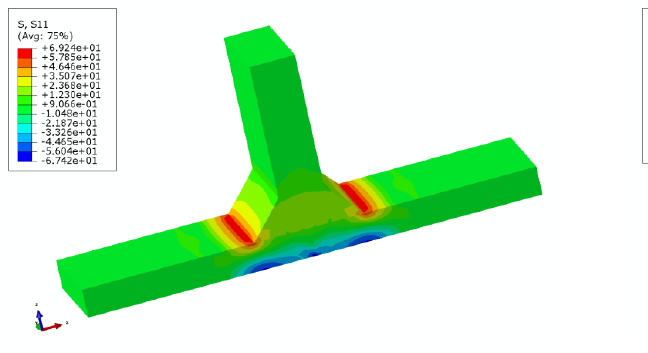
Figure 8: Stress results of 5A06+5083 T-joint. Figure 9: Stress results of 5A06+5A06 T-joint.